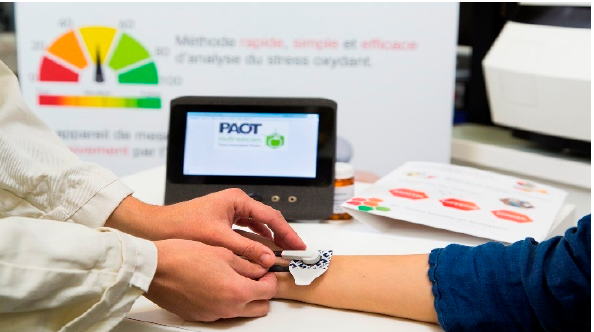
Figure 1. Photography of the electrochemical equipment (Oxystress Analyzer) allowing the measurement of SOSS in a non-invasive way. For details, see the Material and Methods section.